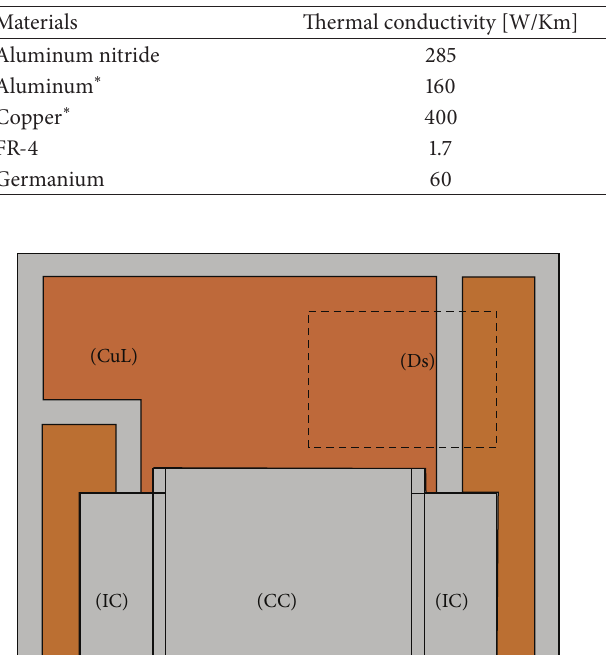
Table 4: Proprieties of materials (materials marked with ∗ are COMSOL built-in materials).